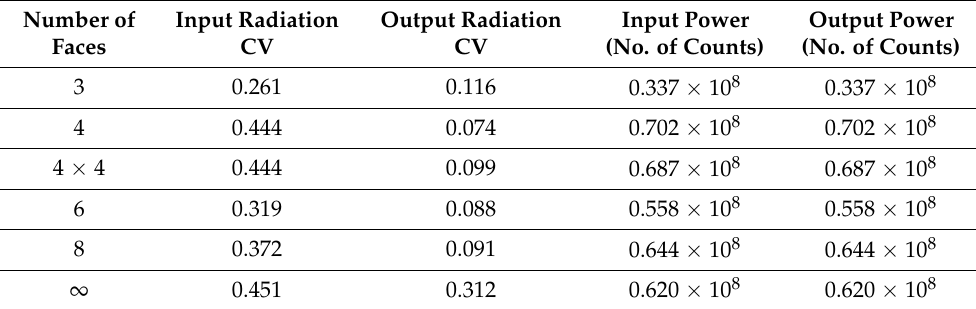
Table 4. CV and power at homogenizer entrance and exit, as a function of the number of faces, for the following conditions: Total length = 350 mm; position = 0 (centered at the theoretical focal point), tilt angle = 0 ◦